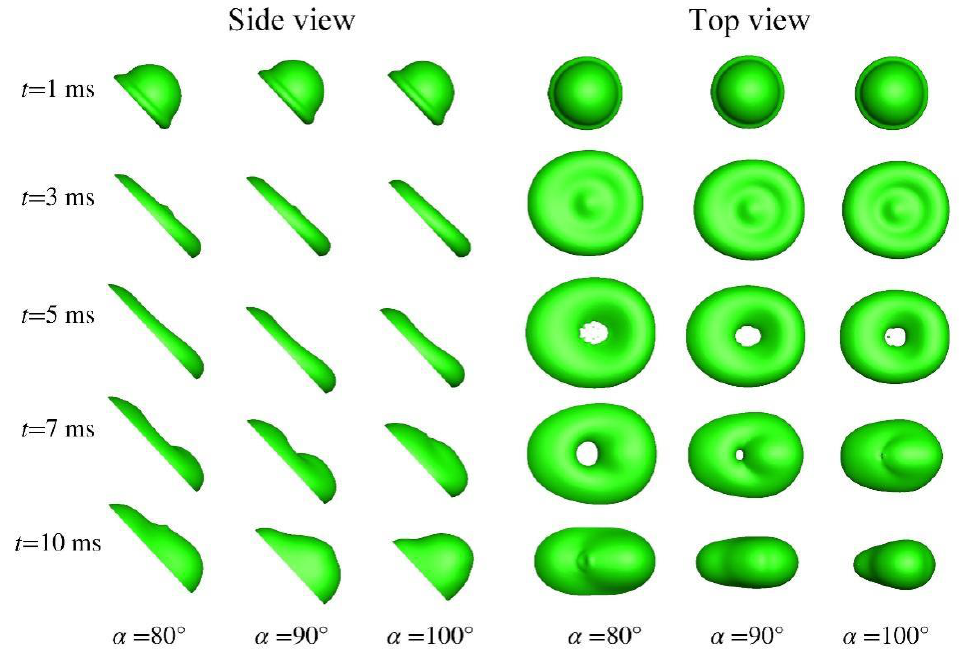
◦ ) of water droplet.